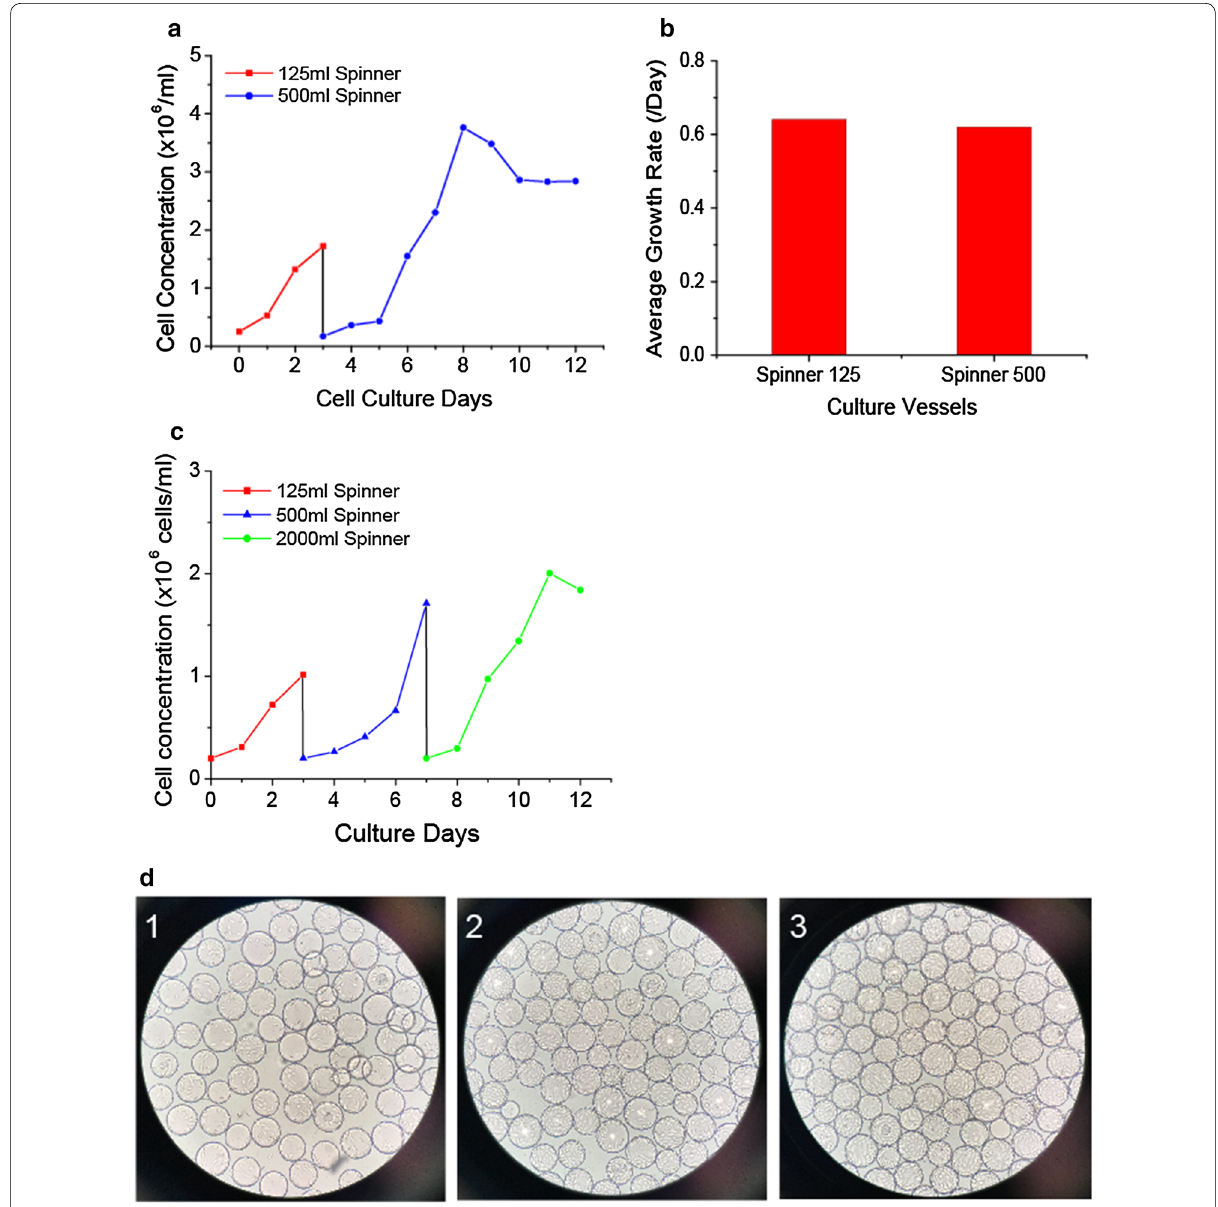
Fig. 3 Bead-to-bead transfer studies in spinner flasks. a HEK293T cell growth curve of bead-to-bead transfer study in 125 ml and 500 ml spinner flasks. b Growth rate comparison of HEK293T cells before and after microcarrier bead-to-bead transfer. c Vero cells bead-to-bead transfer studies in 125, 500, and 3000 ml spinner flasks. d Vero cell growth pictures in 3000 ml spinner flask on day 1, day 3 and day